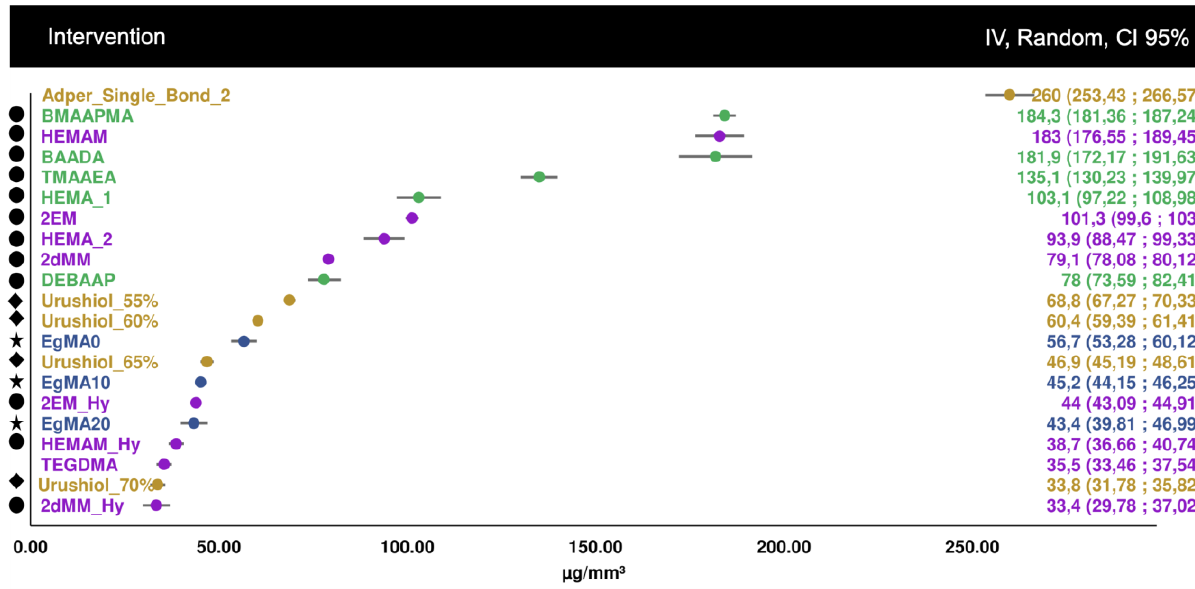
Figure 6. Forest plot that includes data of the water sorption measured in 4 individual studies. Symbol legend: ★ eugenyl methacrylate derivatives; ● methacrylamide derivatives.